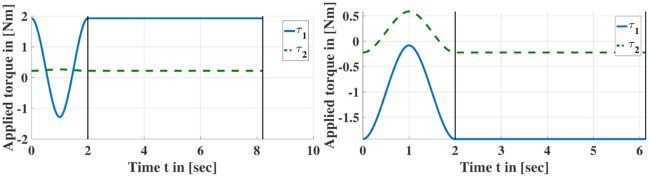
Examples of torque profiles for symmetry discovery. First, a torque spline is applied with the same initial and terminal absolute torque values. Subsequently, a constant torque is commanded until the manipulator settles at a configuration.